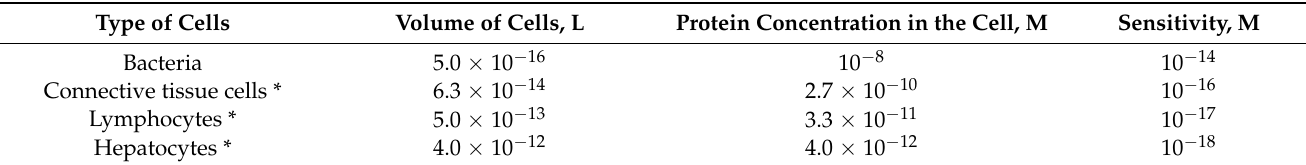
Table 2. Assessment of analytical sensitivity sufficient for detecting a single molecule in the sample consisting of 10 6 cells [49].